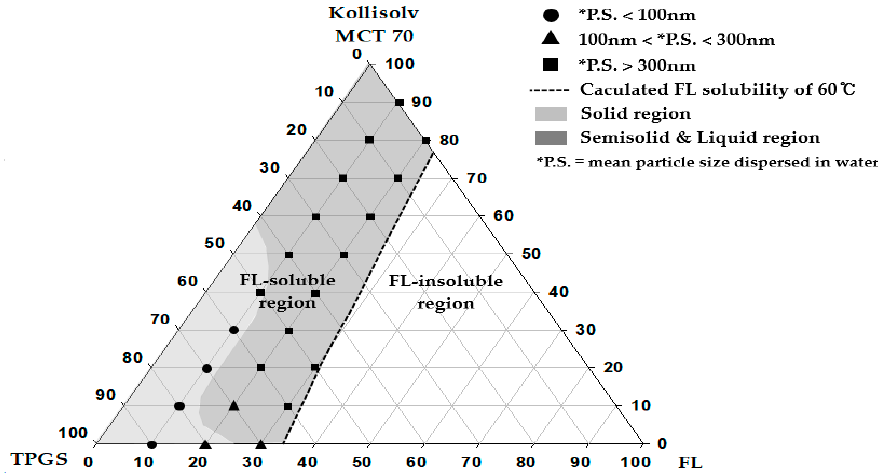
Figure 1. Pseudo-ternary phase diagram composed of flurbiprofen (FL), tocopherol polyethylene glycol 1000 succinate (TPGS), and Kollisolv MCT 70. Table 2. Physical properties according to representative formulations.